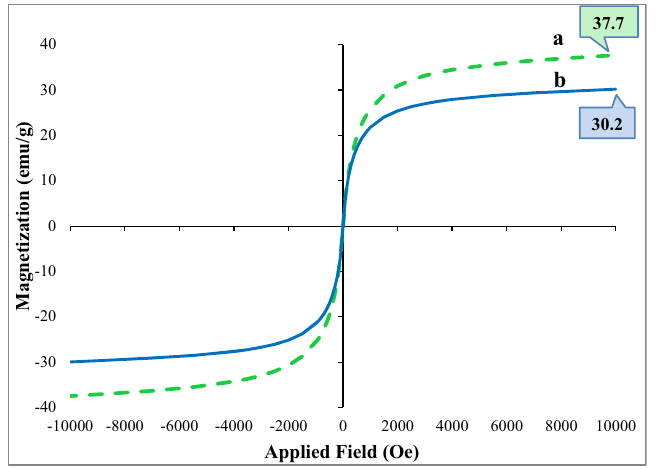
Figure 5. Magnetic-hysteresis curves of ( a ) ZnS–CuFe 2 O 4 and ( b ) agar supported ZnS/CuFe 2 O 4 .